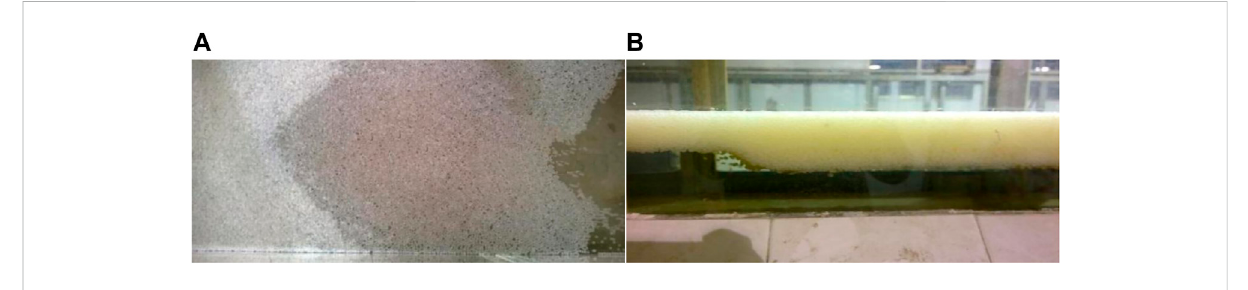
FIGURE 4 Head of the ice jam in the second case [ fl ow direction is from (B) to (A)